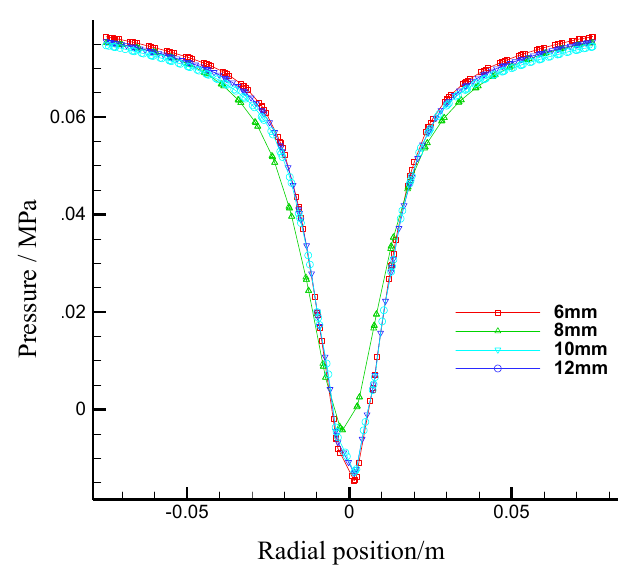
Figure 19. Pressure distribution inside cyclone with different II underflow pipe.